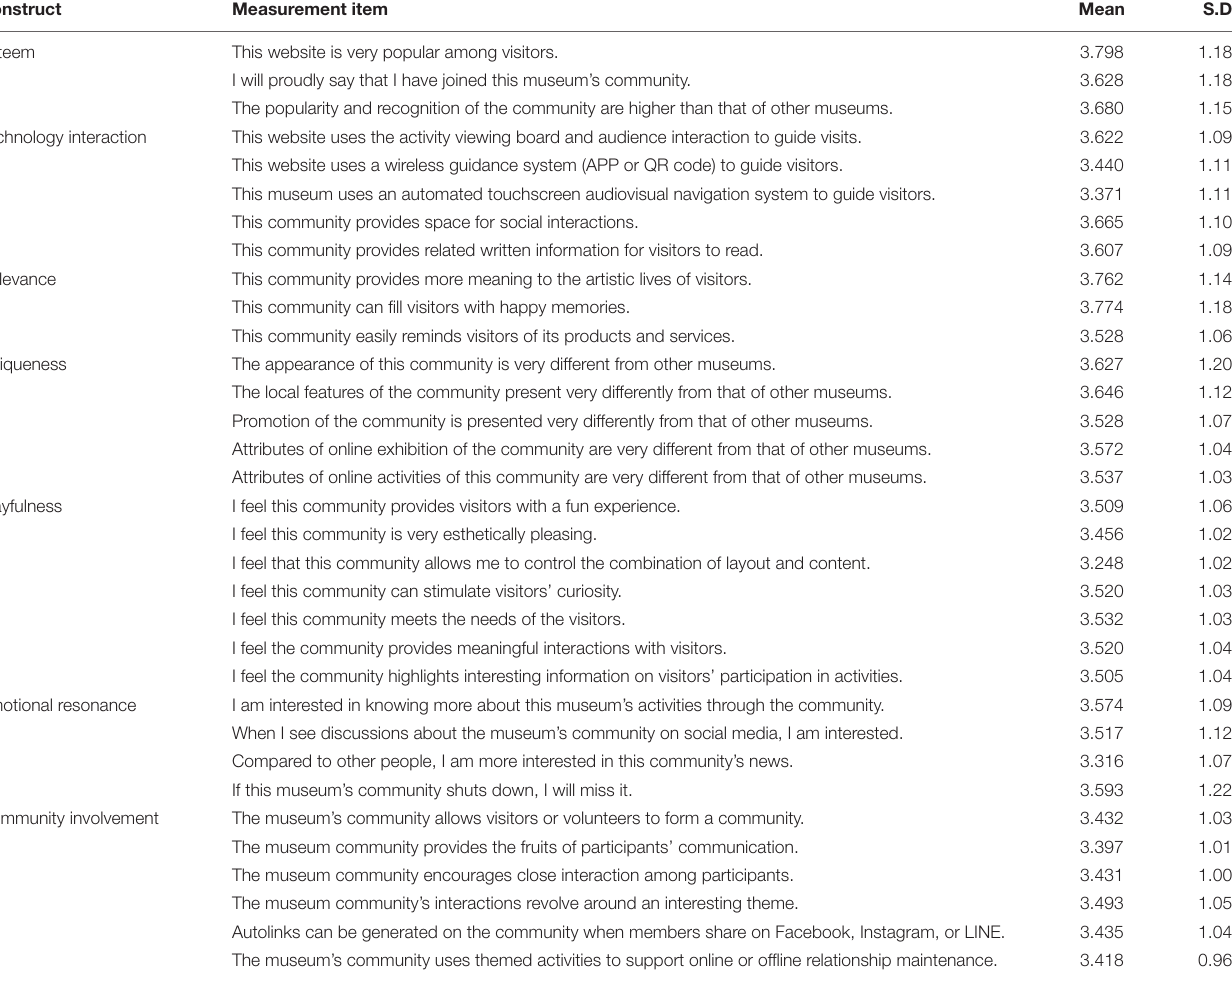
TABLE A1 | Questionnaire survey